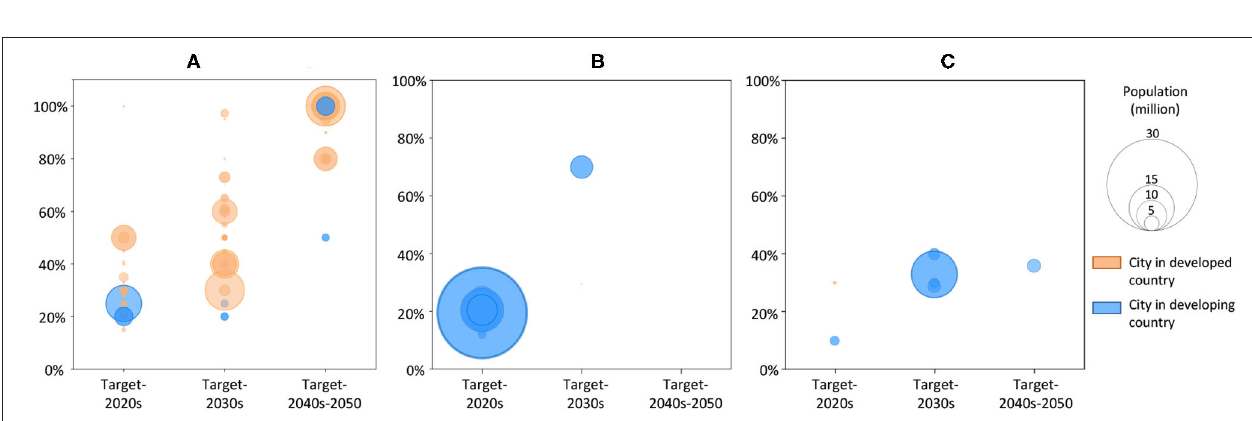
FIGURE 5 | The (A) absolute emission reduction target, (B) intensity target, and (C) baseline scenario target proposed for GHGs emission mitigation in